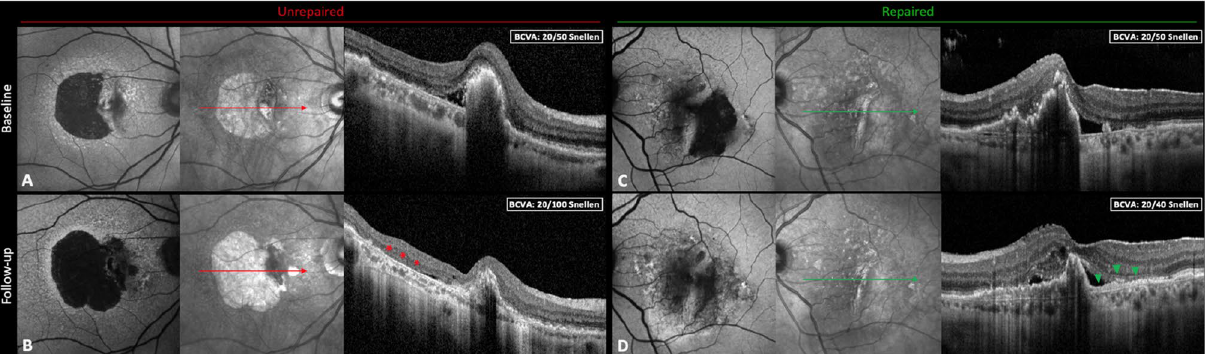
Figure 1. Multimodal imaging of unrepaired vs. repaired tears of the retinal pigment epithelium (RPE). ( A ) and ( B ) composites depict the imaging features of a case of large RPE tear without signs of tissue repair. Over the follow-up the hypo-autofluorescence due to the absence of the RPE gradually enlarges as documented by blue-light autofluorescence (BAF), while the retina rests on an area of exposed Bruch’s membrane on optical coherence tomography (OCT; red asterisks). On the other hand, ( C ) and ( D ) composites show a case characterized by RPE healing. At follow-up, shrinkage of the RPE defect can be noticed using BAF, and the growth of the RPE layer with an underlying proliferative tissue is visible on OCT (green